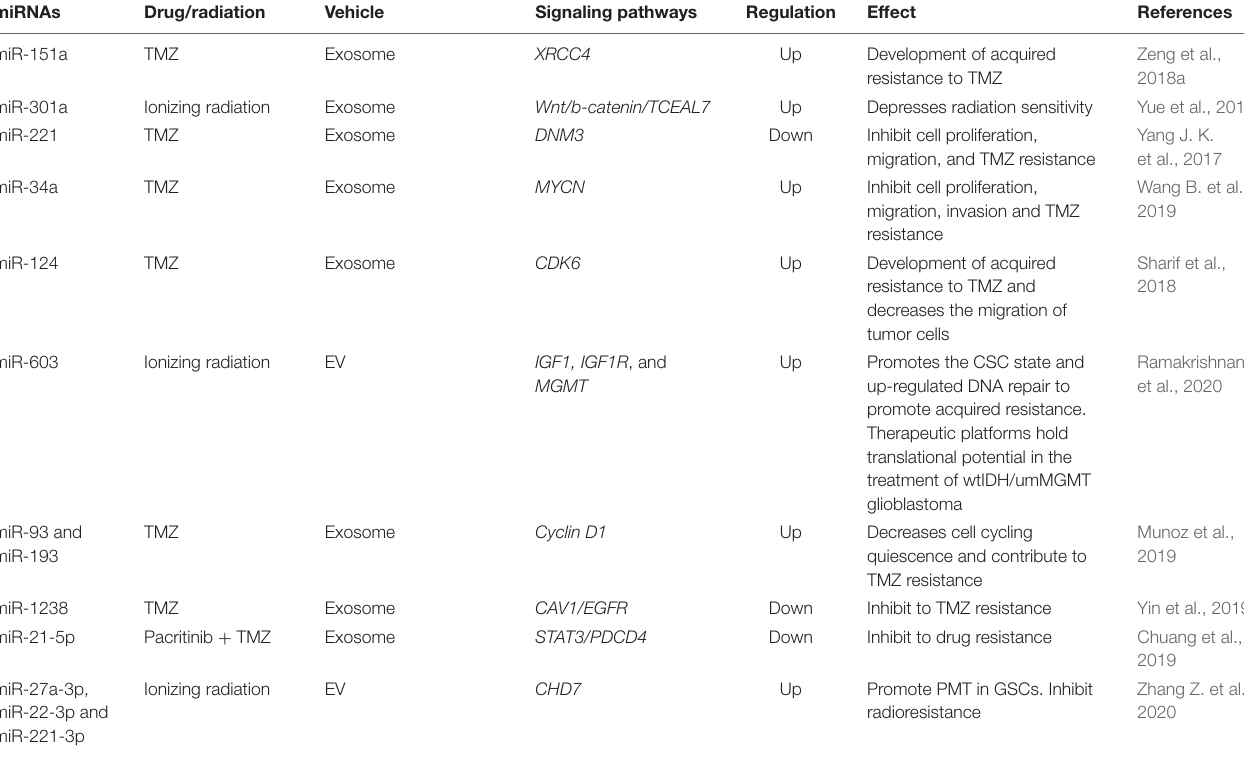
TABLE 4 | MiRNAs in extracellular vesicles (EVs) and their signaling pathways through which they may be responsible for glioblastoma therapeutic resistance.